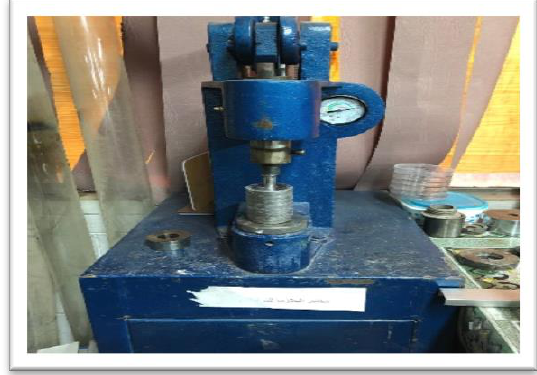
Figure 1: The Hydraulic piston.